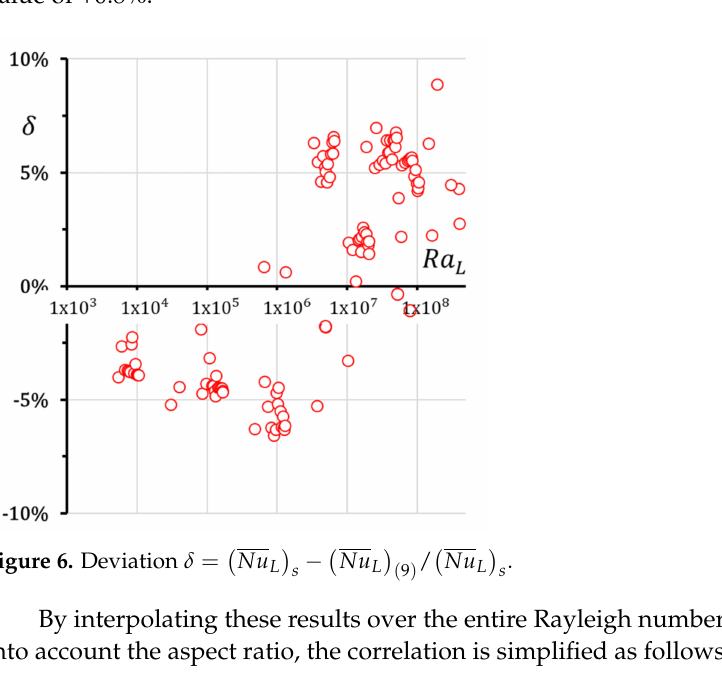
(cid:1) (cid:0) Nu L were compared to those ( 9 ) (cid:0) (cid:0) (cid:0) (cid:1) (cid:1) (cid:1) (cid:1) − (cid:0) Nu Nu L Nu L Nu L . Deviation δ = / L ( 9 ) s s s